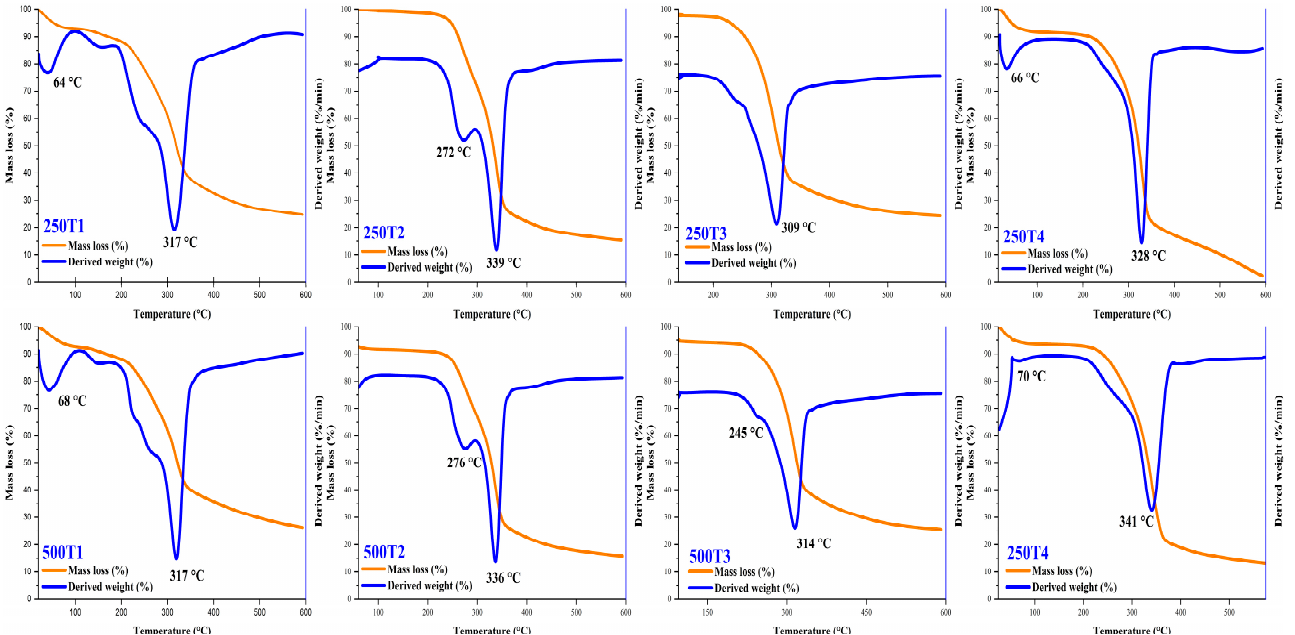
Figure 9. TG and DTG curves of the biosorbents obtained from the fractions of 250 and 500